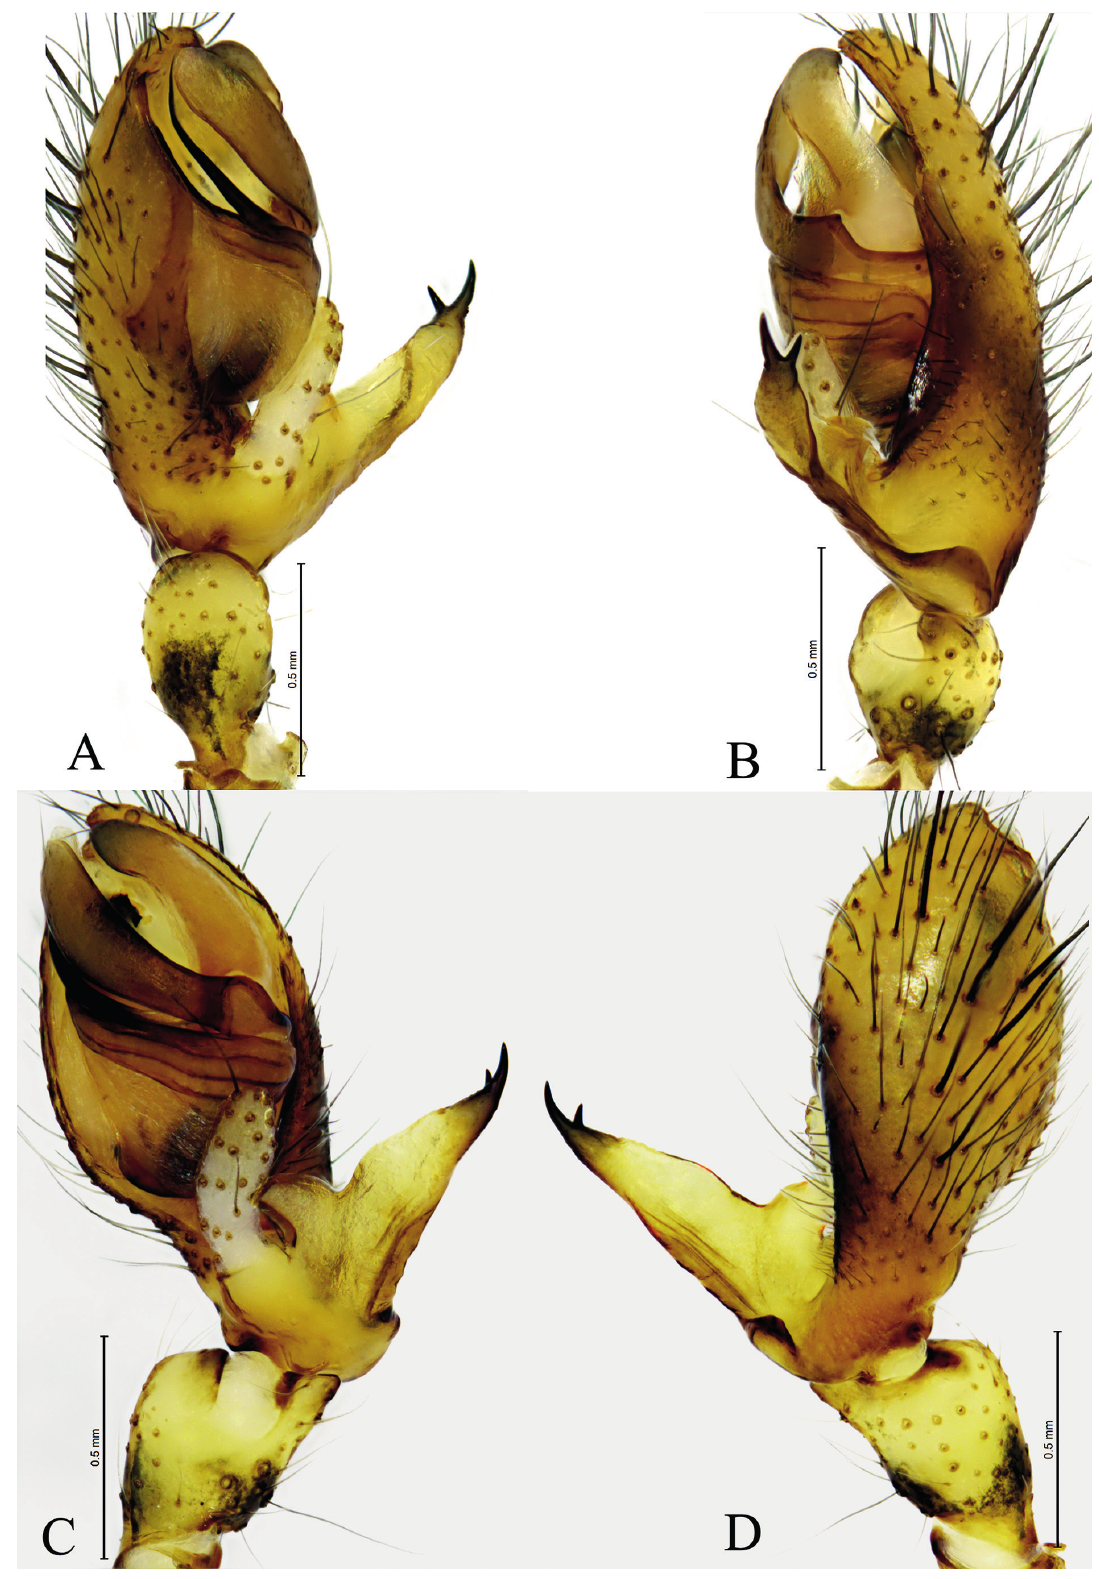
Fig. 9. Meta gyirong sp. nov., ♂, holotype (SWUC-T-TEg-04-01). A . Left palp, prolateral view. B . Same, ventral view. C . Same, retrolateral view. D . Same, dorsal